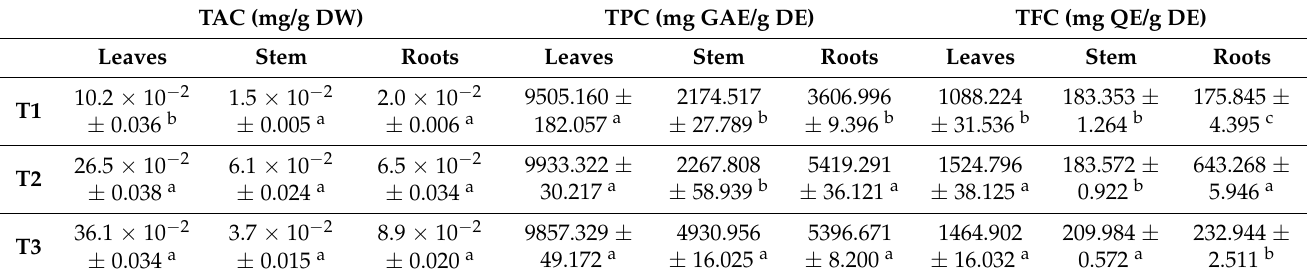
Table 4. Effects of different treatments on total anthocyanin content, total flavonoid content, and total phenolic content in various parts of M. malabathricum L. methanolic extracts.